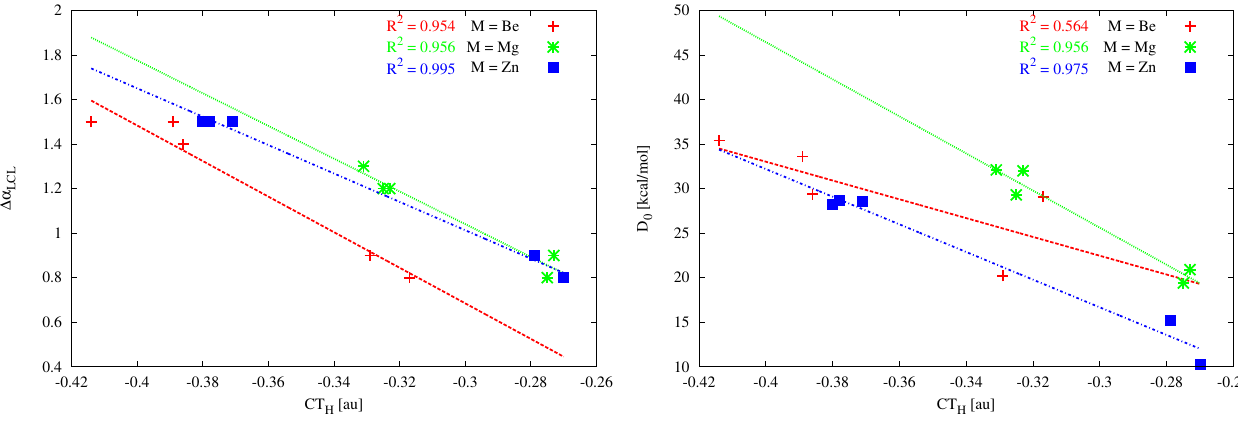
Figure 11. Relationships between charge transfer (CT H ) and either the change in the LCL angle ( ∆ α LCL ) or the dissociation energy ( D 0 ) obtained for the cyclopropenylidene · · · MX 2 (M = Be, Mg, Zn)